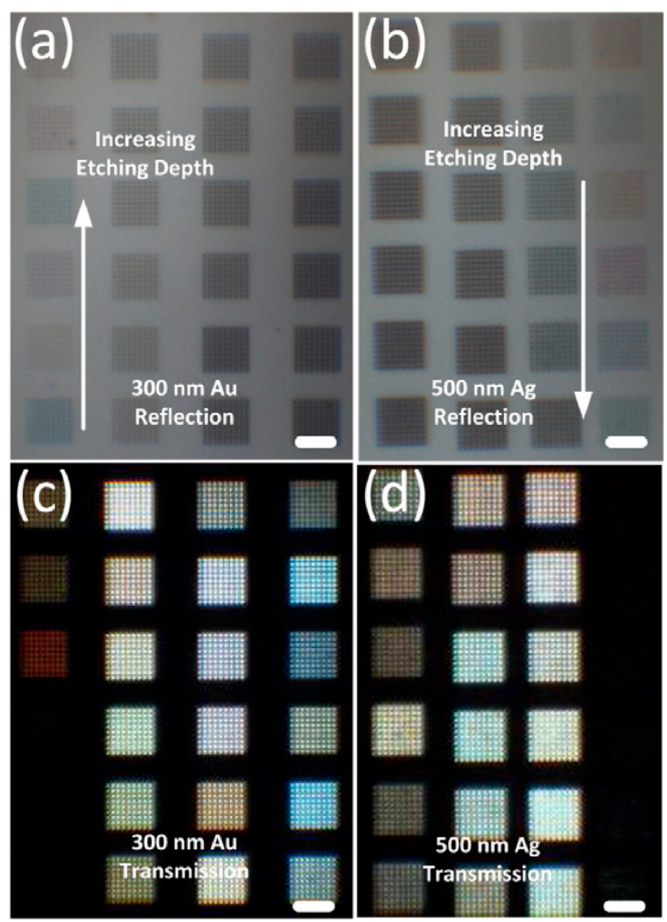
Figure 8. Optical images for ( a ) 300 nm gold under reflection mode; ( b ) 500 nm silver under reflection mode; ( c ) 300 nm gold under transmission mode, and ( d ) 500 nm silver under transmission mode with varying etching depths of coaxial apertures. Scale bars, 5 μ m. All figures are adapted from reference [94].